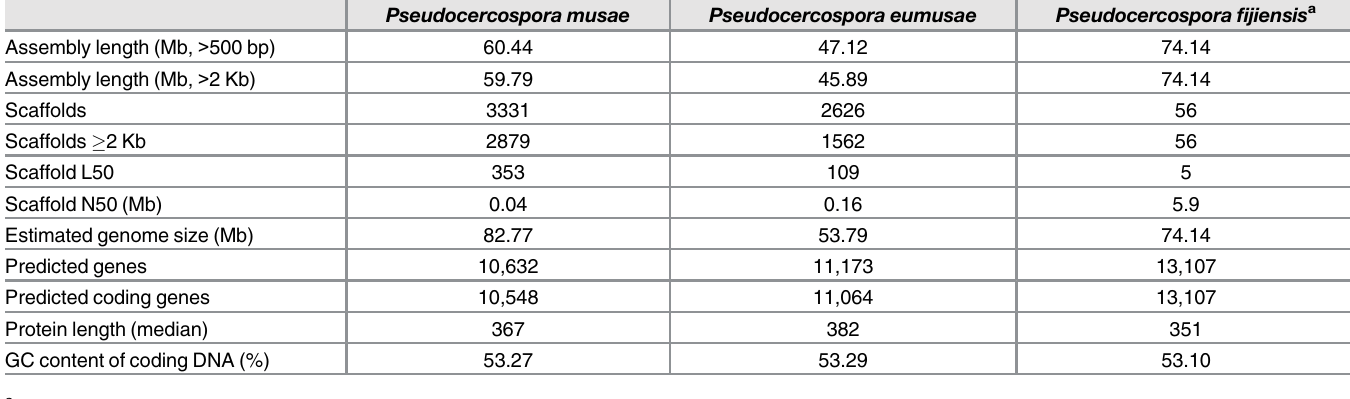
Table 1. Summary of the genome assembly and annotation